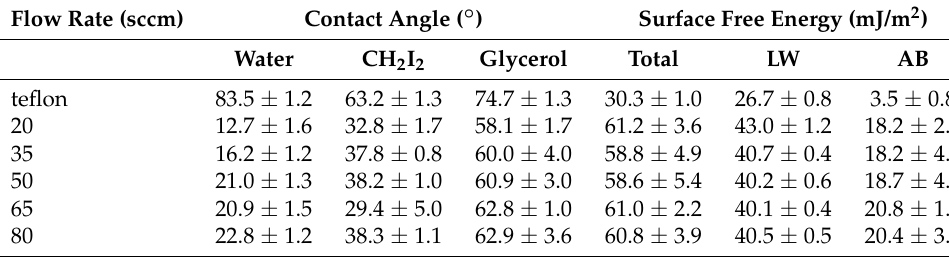
Table 2. The contact angles for different liquids and surface free energy, and its components, of PB films deposited at different monomer flow rates. Teflon marks bare